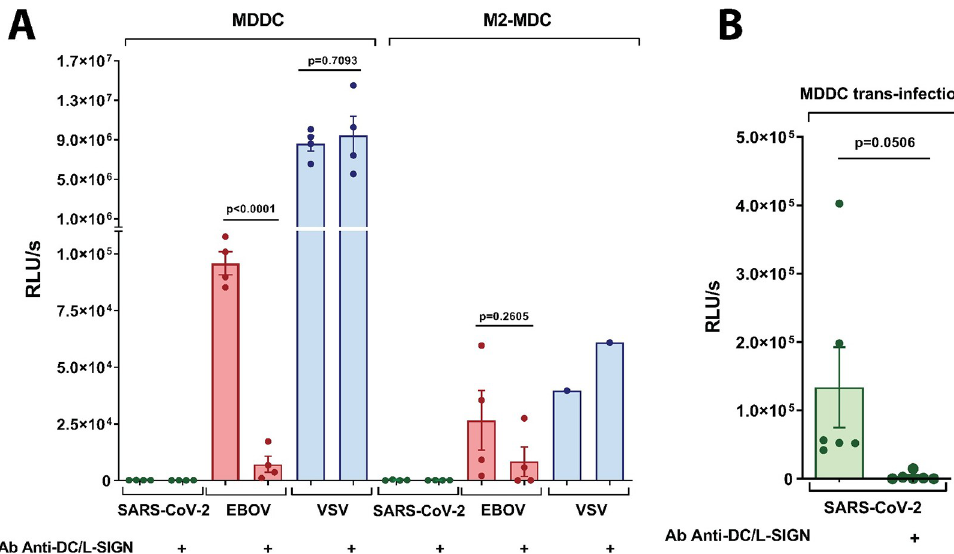
Fig 4. SARS-CoV-2 cis- and trans-infection of monocytes-derived antigen presenting cells. (A) Direct infection of primary cells: monocyte-derived dendritic cells (MDDCs), and M2 monocyte-derived macrophages (M2-MDM) with SARS-CoV-2, EBOV-GP and VSV-G pseudovirions. Bars represent mean ± SEM of mean of two independent experiments with cells from different donors performed in duplicates. Individual results are presented as scattered dot plot. As a control of inhibition of infection mediated by DC-SIGN, anti-DC-SIGN Ab was used. (B) MDDCs trans-infection of SARS-CoV-2 pseudovirions onto Vero E6 cells. Bars represent mean ± SEM of three independent experiments with cells from different donors performed in duplicates. Individual results are presented as scattered dot plot. As a control of inhibition of trans- infection mediated by DC-SIGN, anti-DC-SIGN Ab was used. Infection values are expressed as Relative Light Units (RLUs). Statistical significance was calculated by